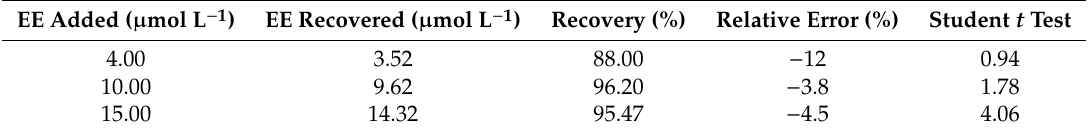
Table 12. Determination of Ethinyl estradiol in Milk